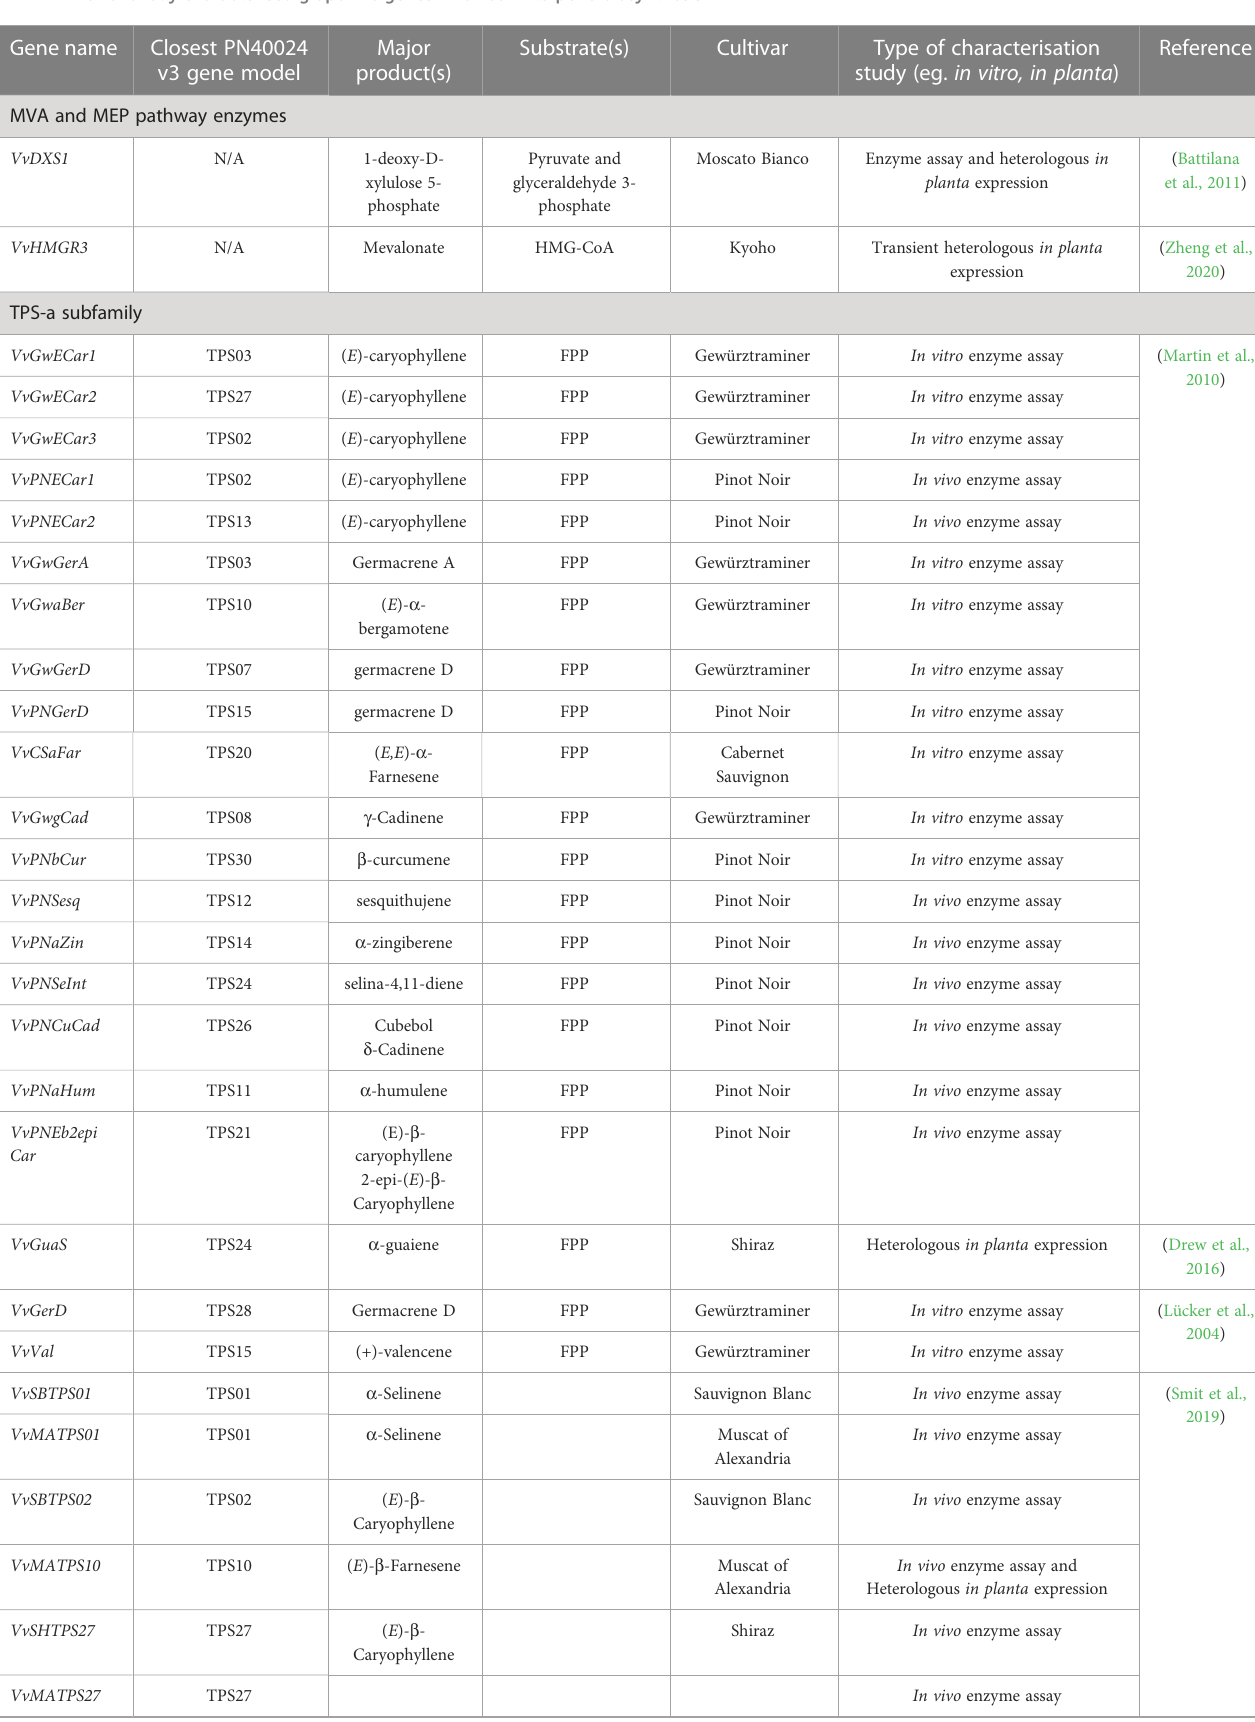
TABLE 1 Functionally characterised grapevine genes involved in terpene biosynthesis. Gene